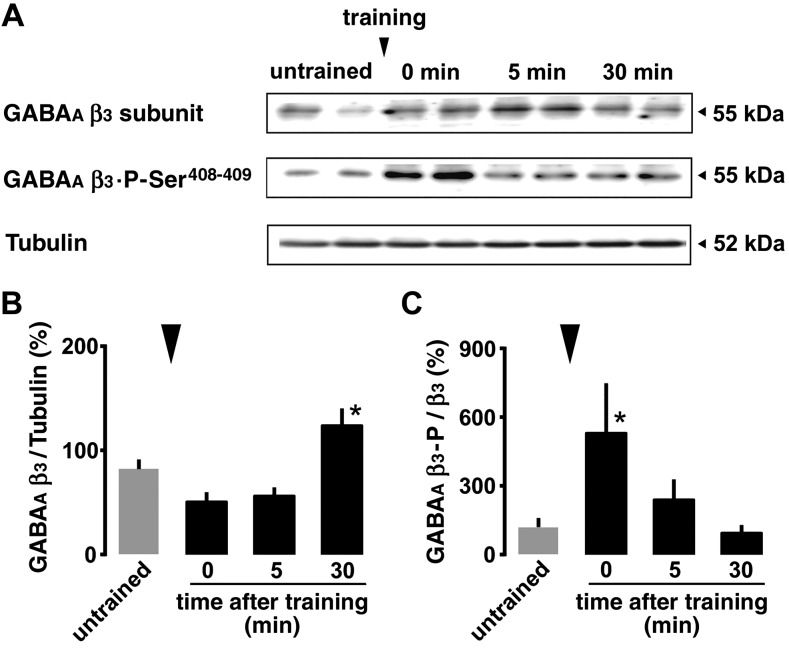
Rapid Ser408−409 phosphorylation of GABAA receptor β3 subunit. A) Whole-cell fractions of dissected dorsal CA1 were analyzed. Molecular masses of standards are indicated on the right. B) Total GABAA receptor β3 subunit was normalized to total β-tubulin, showing an increase in the subunit 30 min after the training. C) The phosphorylation-specific signals of Ser408−409 were normalized to the total GABAA receptor β3 subunit. IA training increased Ser408−409 phosphorylation within 1 min after the training (0 min). *P < 0.05, **P < 0.01 vs. untrained; n = 9 in all groups. Error bars indicate ± sem. ▼ indicates the timing of training.